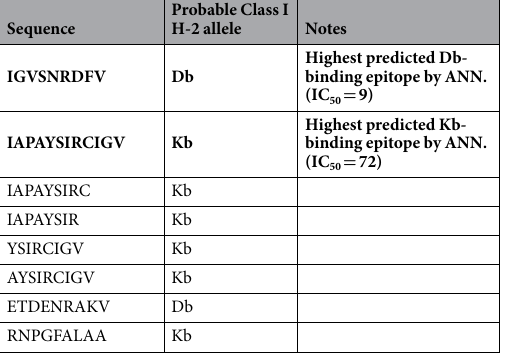
Table 2. Individual peptides tested for CD8 + T cell cytokine